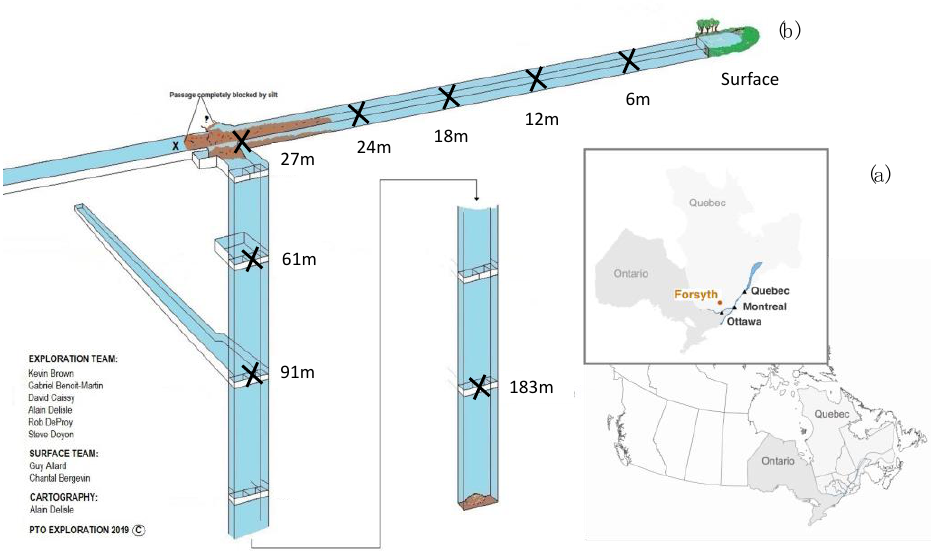
Figure 1. ( a ) Localization map of the Forsyth mine in Quebec, Canada (QGIS), ( b ) Forsyth mine cartography. X represent sampling localization.